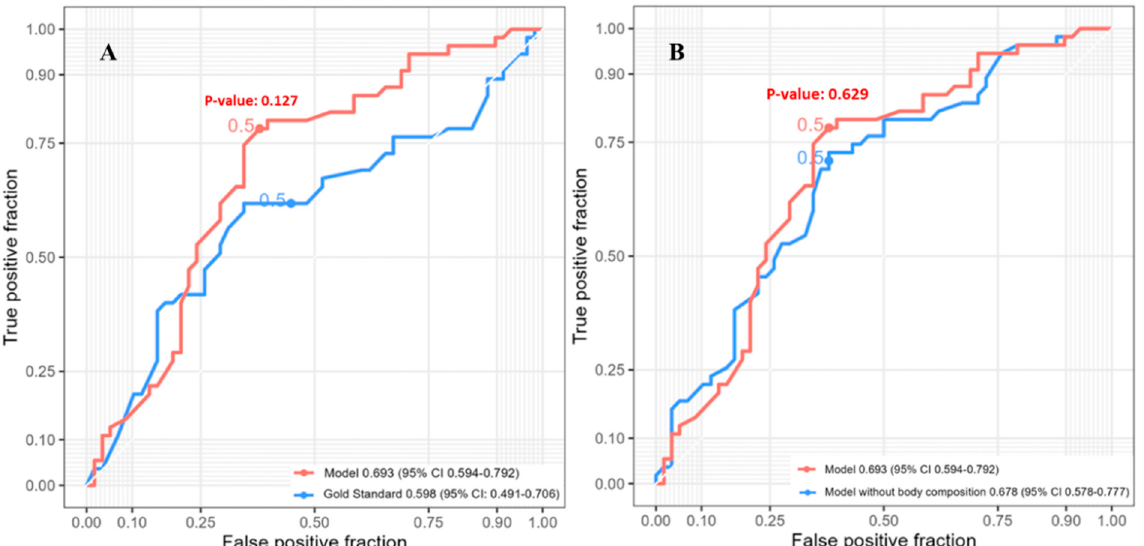
Figure 2. ROC curves of random forest models predicting three-year post-esophagectomy survival (n = 113). ( A ) Full random forest model and reference model. ( B ) Random forest models with and without body composition variables. ROC = receiver operating characteristic.